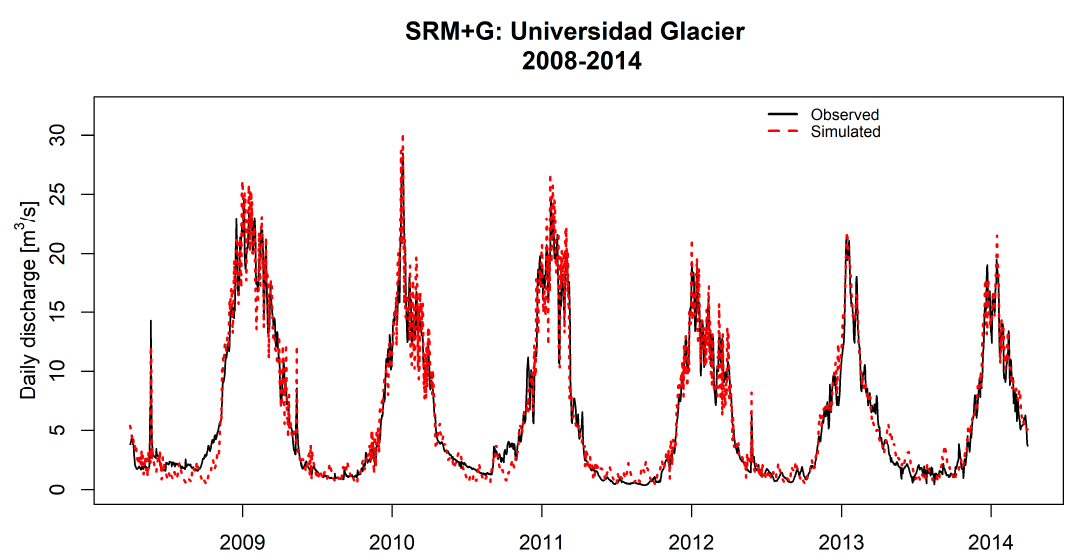
Figure 3. Hydrogram of the SRM+G hydrological model at the San Andrés discharge station. The calibration period corresponds to the even years and the validation period to the odd years. The high discharge periods extend from November to March, during which the melting period can be recognized.